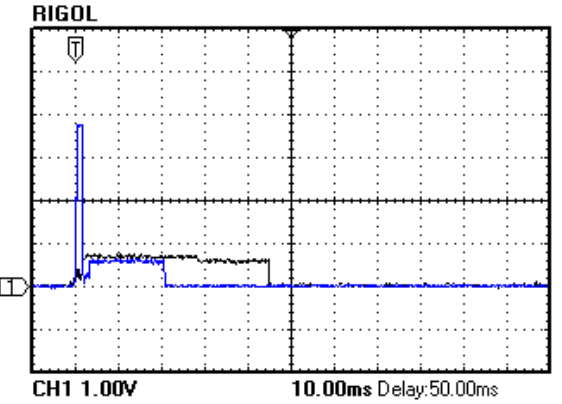
Figure 3. Current consumption of cyclic redundancy check (CRC-8) generator code with fixed frequency (black) and switched frequency (blue) for data size 500 bytes.